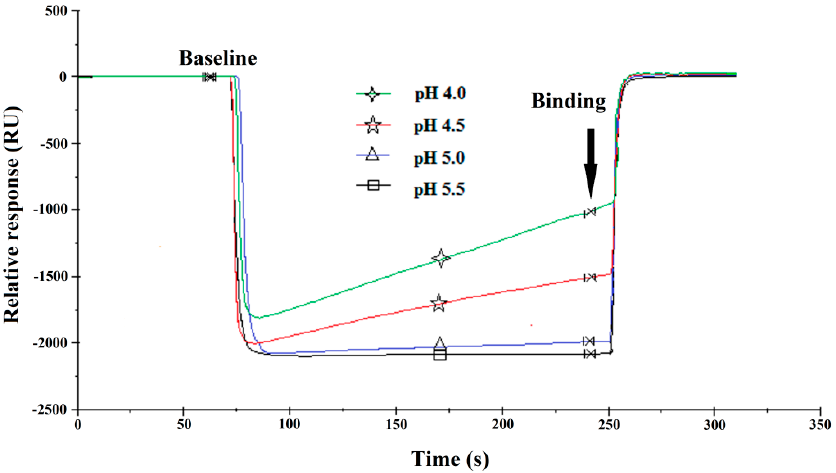
Figure 3. Results of the ENRO-OVA conjugate immobilized on the SPR chip in 10 mM acetate buffer solution at different pH values.